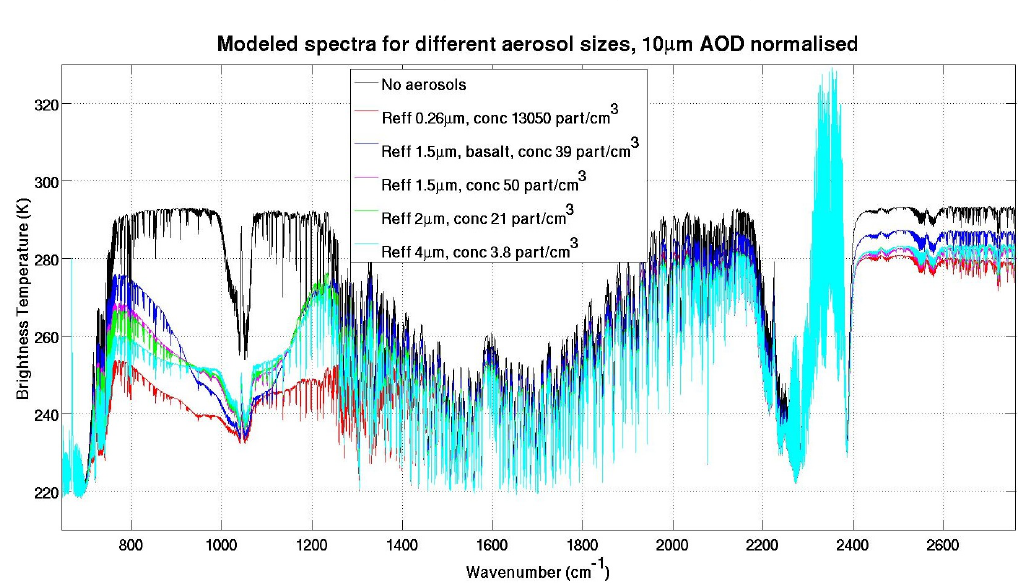
Figure 1. Modeled spectra without aerosols and for different aerosol sizes. Aerosols were placed from a 0- to 18-km altitude with a 10 µ m (1000 cm − 1 ) aerosol optical depth (AOD) of 2.2. The dark blue spectrum has been modeled using the refractive index of basalt, while all of the others were obtained with the GEISA/HITRAN volcanic ash refractive